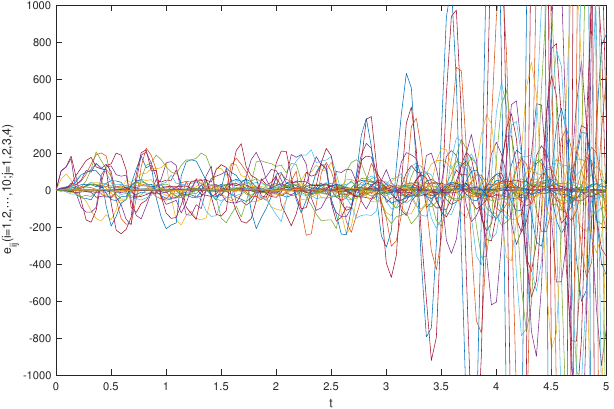
Figure 9. Synchronization errors e ij ( i = 1,2, · · · ,10; j = 1,2,3,4 ) of the fractional-order system (32) and (33) without the controllers.